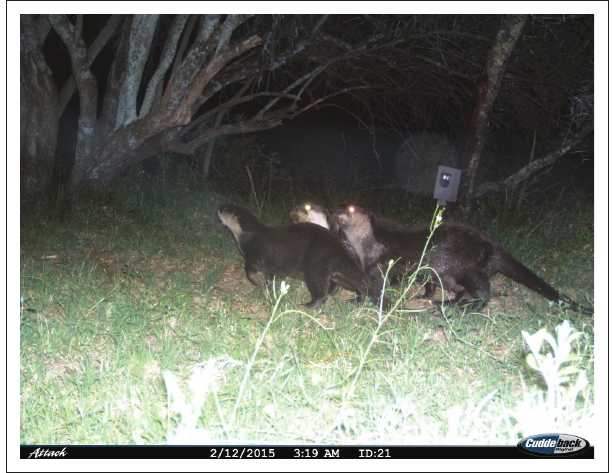
FIGURE 3 : Three African clawless otters ( Aonyx capensis ) photographed on a camera trap during a brown hyaena ( Parahyaena brunnea ) population assessment (Comley 2016) in the Mountain Zebra National Park, Eastern Cape, South Africa. Permission to use the image granted by Jessica